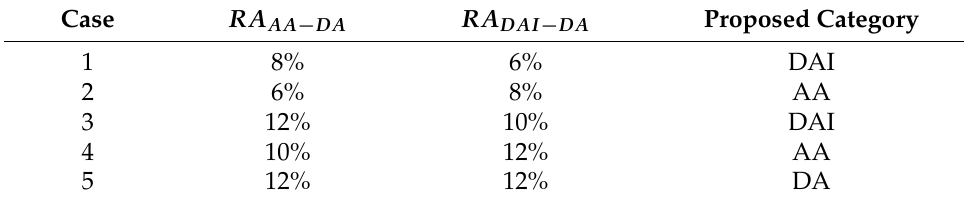
Table 4. Rule for determining class